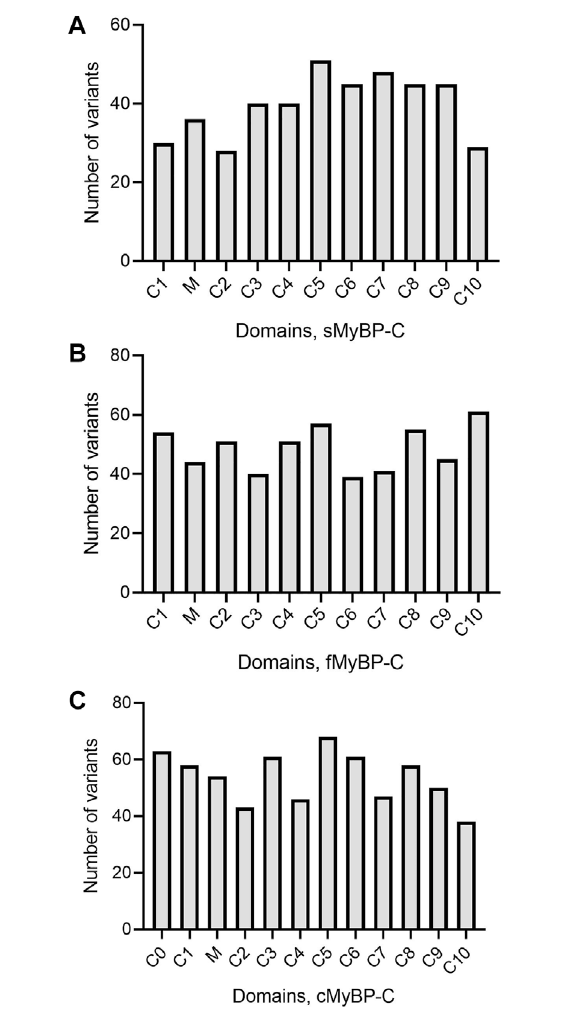
MyBP-C paralogs . Heterogeneous distribution of variant frequency observed in the domains of the MYBPC family. (A – C) sMyBP-C has the lowest number ofvariantsacrossdomains,comparedtootherparalogs,andC5domain was the most mutated domain with the highest number of variants in the MYBPC